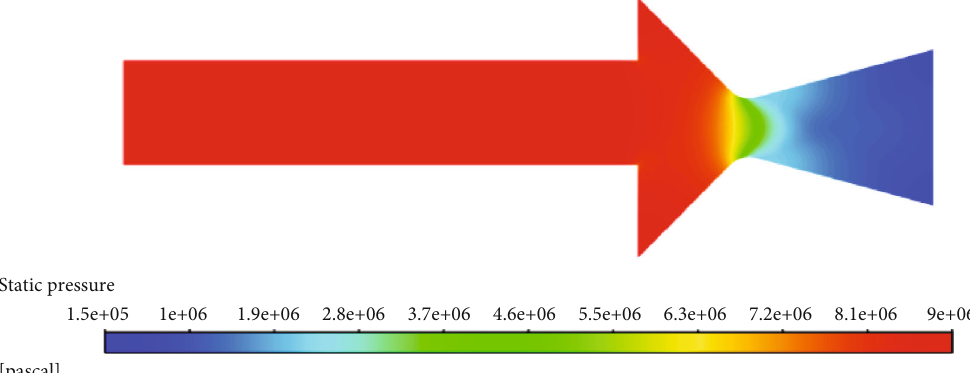
Figure 14: Contour of pressure distribution.